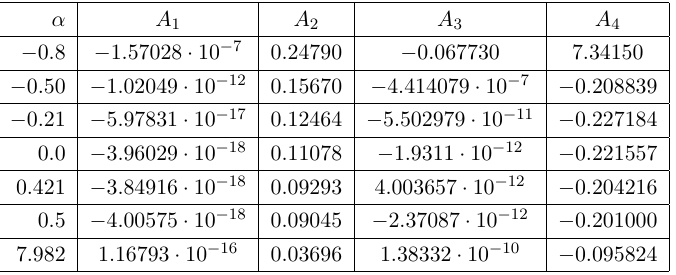
Table 1 . The coe(cid:14)cients of the (cid:12)t function in (D.7) for di(cid:11)erent values of (cid:11) . Notice that for values of (cid:11) close to (cid:0) 1 the coe(cid:14)cient A 2 di(cid:11)ers more signi(cid:12)cantly from the expected zero value and thus our numerical results are less